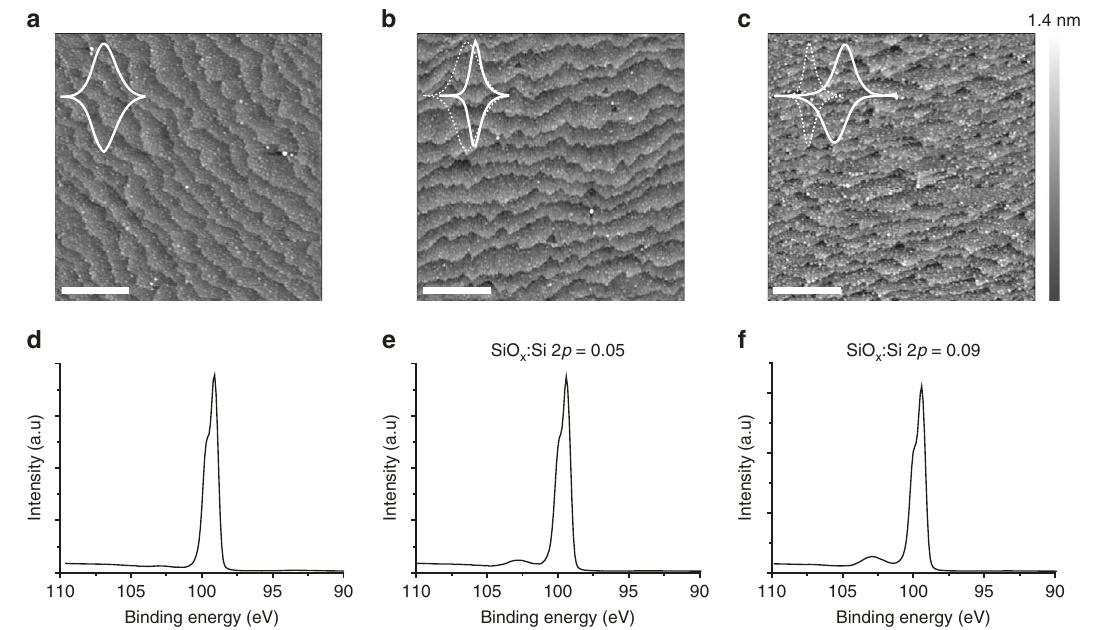
Fig. 3 Anodic monolayer stripping. Tapping mode AFM images (2 × 2 μ m) and XPS Si 2 p narrow scans for S-2 samples on Si(111). Cyclic voltammograms are shown as insets to the AFM images. Data for as-prepared samples are in a and d , and data after the short potential step (0.3 V, 1 min) that lead reproducibly to narrow voltammetric waves (ca. 60 mV fwhm) are in b and e . Owing to the kinetic factors, the narrow waves are lost upon more extensive oxidation of the electrodes ( c , f ). High-energy emissions from silicon oxides (Si + − Si 4+ ) are evident in e and f , and the evolution of the SiO x :Si 2 p peak area ratios appear as labels in the XPS panels. a Small protrusions are observed (222 protrusions µ m − 2 , which are on average 0.4 nm in height and 5 nm in radius) over the staircase structure of the 〈 111 〉 surface ( R q of 0.08 ± 0.02 nm ( R tm = 0.15 nm) on the terraces and R q = 0.20 ± 0.15 nm ( R tm = 0.63 nm) over the whole area). The number of protrusions increases upon the anodic treatment (327 protrusions µ m − 2 in b and 945 protrusions µ m − 2 in c ) and tracks XPS SiO x emissions. For clarity and comparison purposes all the AFM images are normalized to 1.4 nm. The scale bar is 500